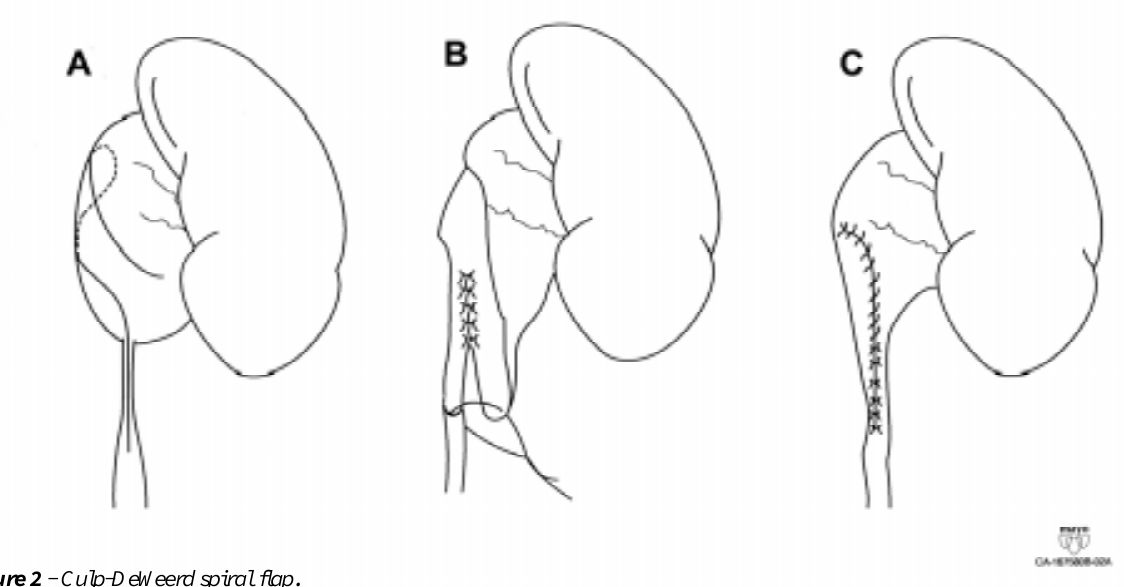
Figure 2 - Culp-DeWeerd spiral